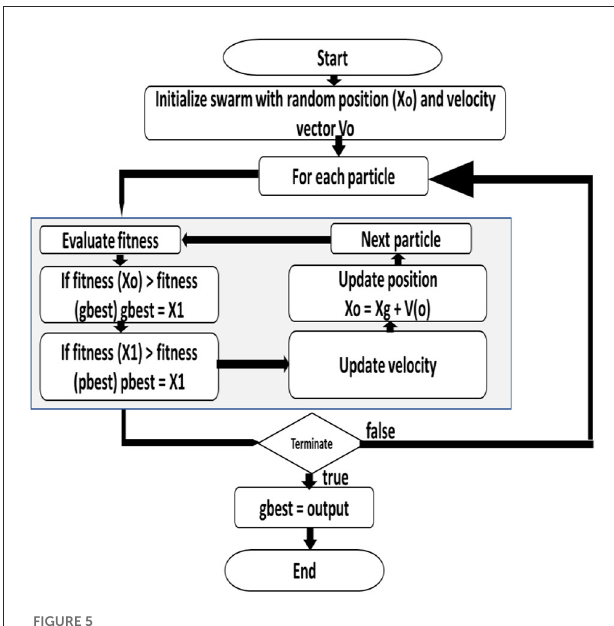
FIGURE5 PSO algorithm schema.